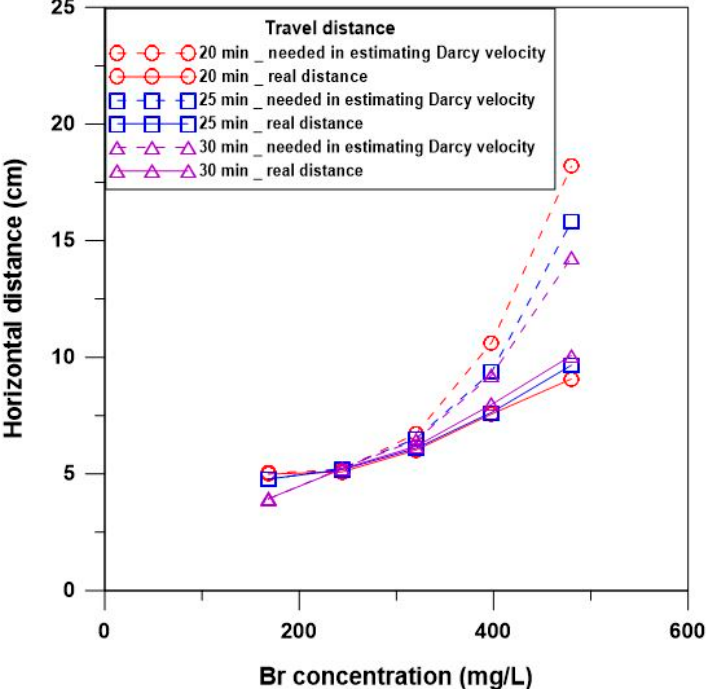
Figure 6. A comparison of the horizontal distance values needed in estimating Darcy velocity with the real horizontal distance values in various drift time and density conditions.